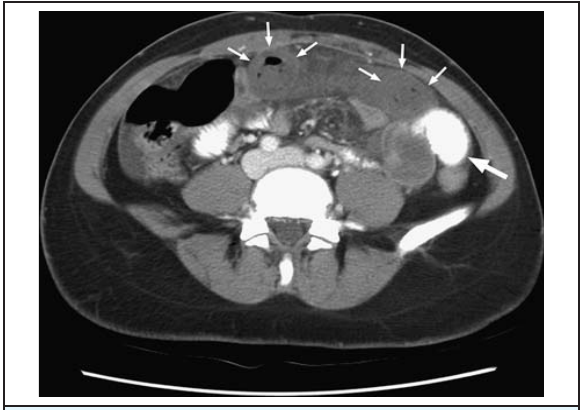
Figure 6. CT scan demonstrating reduced small bowel enhancement and wall thickening (small white arrows) in a patient with SBO and strangulation. Note that the presence of dense oral contrast obscures the assessment of bowel wall enhancement in that segment (large white arrow).